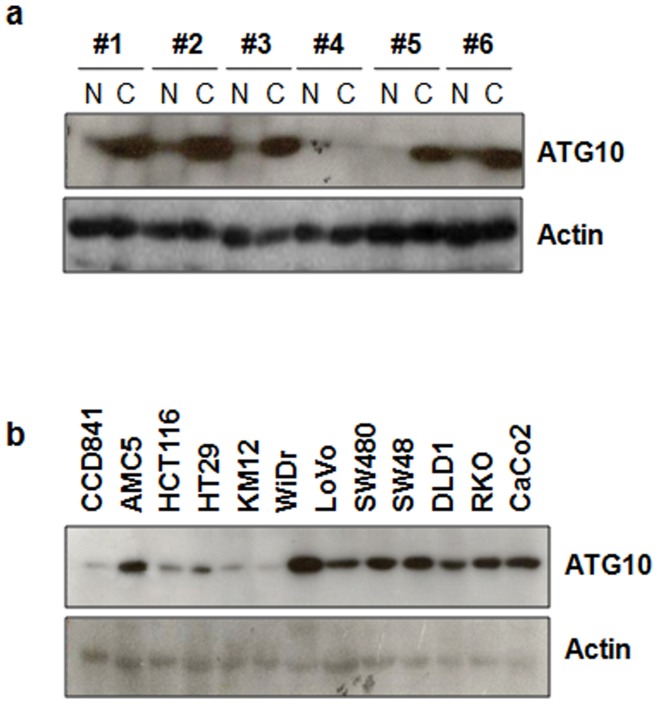
ATG10 expression is increased in colorectal cancer.(a) ATG10 expression in colorectal tissues was assessed by Western blot analysis (n = 37; T, tumor tissue; N, corresponding normal tissue). ATG10 expression was normalized to actin expression (n = 37). (b) Western blot analysis of ATG10 expression in several colorectal cell lines (Normal - CCD841; Cancer - HCT116, HT29, KM12C, WiDr, LoVo, SW480, SW48, HCT15, DLD1, RKO, CaCo2). ATG10 expression was quantified by densitometry.